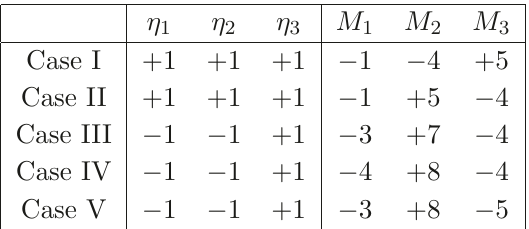
Table 2 . The five patterns of allowed model setups. Higgs field H carries a flux number and Z 2 parity ( M 1 , η 1 ). Similarly, left- and right-handed lepton L and N carry ( M 2 , η 2 ) and ( M 3 , η 3 ),